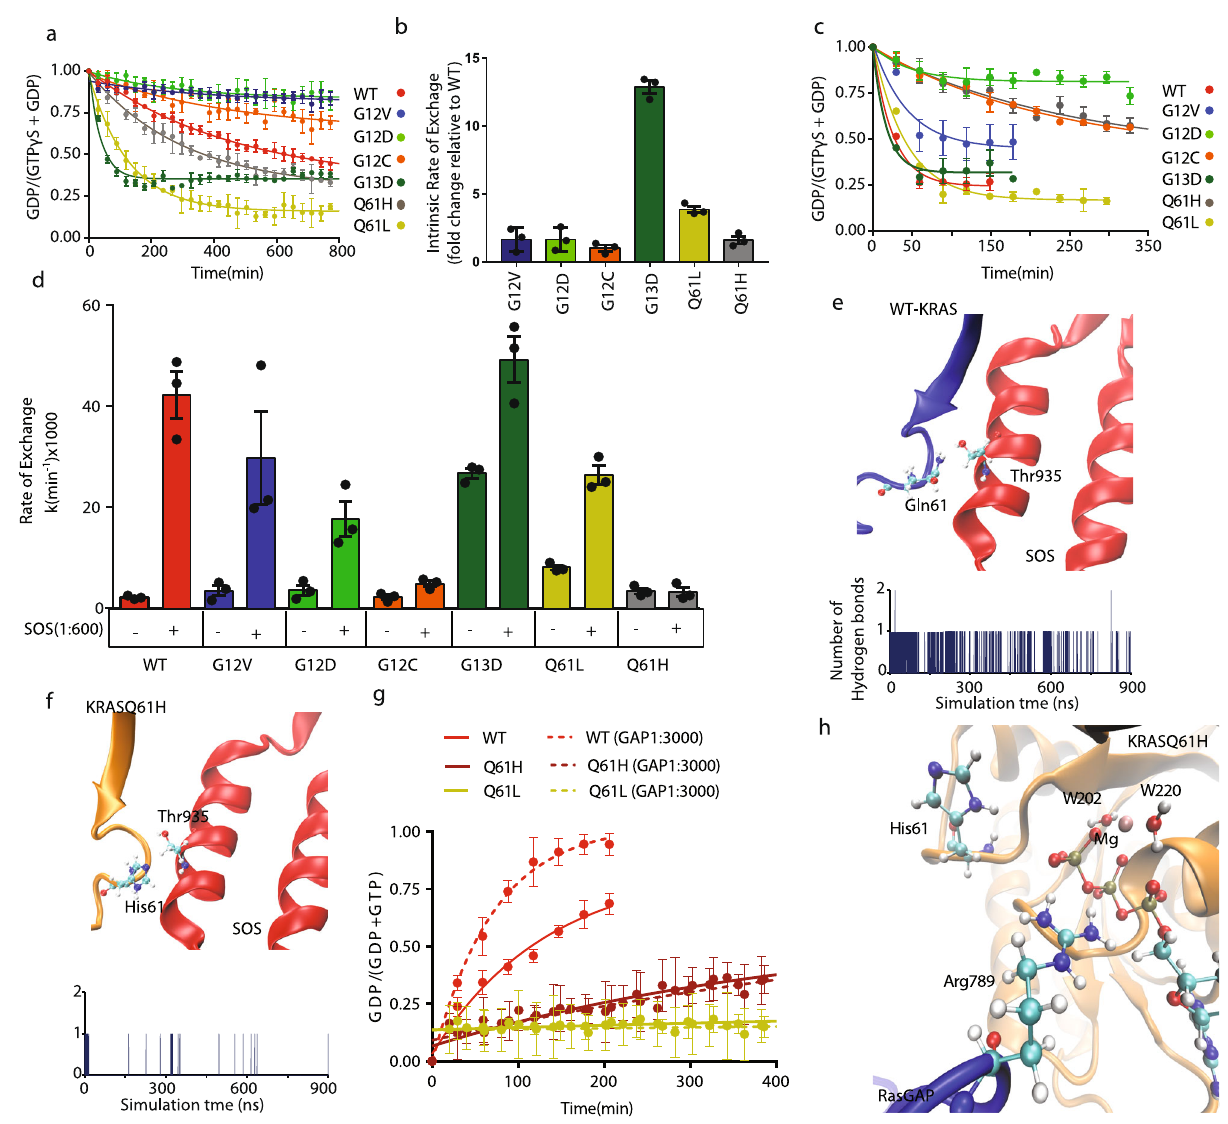
Fig. 2 KRAS Q61H is insensitive to GEF and GAP activities. a Intrinsic nucleotide-exchange curves of wild-type (WT) and mutant KRAS obtained from real-time NMR experiments. A tenfold molar excess of GTP γ S was added to GDP-loaded KRAS at t = 0 and the GDP-bound fraction remaining was monitored over time by NMR. The data were fi t to one-phase exponential decay functions. The nucleotide-exchange curves do not go to zero, because the nucleotide exchange equilibrates at a certain ratio, which is a function of the relative af fi nity of GDP:GTP γ S. b Histogram of intrinsic exchange rates of each mutant determined in a , presented as fold changes for the mutants relative to wild-type KRAS. The error bars indicate the SD of the fold changes. c GEF-assisted nucleotide-exchange curves in the presence of SOS cat (1 : 600 molar ratio SOS : KRAS), measured using real-time NMR. Data were fi t as in a . d Histogram representing the mean intrinsic and SOS cat (1 : 600) assisted exchange rates for wild-type KRAS and mutants obtained from three independent fi tting curves for each mutation. Three pair of peak intensities for each group were used to generate the fi tting curves. The error bars represent SEM of the three exchange rates. e A snapshot ribbon diagram of SOS1 (red) in complex with WT-KRAS (blue) (top panel). Time evolution of hydrogen bonds formed between the Thr935 of SOS and the sidechain of KRAS Q61 (bottom panel). f A snapshot ribbon diagram of SOS1 (red) in complex with KRAS Q61H (orange) (top panel). Time evolution of hydrogen bonds formed between the Thr935 of SOS and the sidechain of KRAS His61. g Intrinsic and GAP-assisted GTP hydrolysis curves for the wild type and Q61H mutant. The GAP domain of RASA1 was added at a ratio of 1 : 3000 to KRAS-GTP ( a , c , e ). h A ribbon diagram of RasGAP (blue) and KRAS Q61H (orange) catalytic site. Dots represent the fraction of GDP-loaded KRAS based on the intensities of GDP- and GTP-speci fi c peaks ( I GDP / I GDP + I GTP γ S ). a , b , g Error bars represent SEM of the three independent pairs of peak intensities used for the